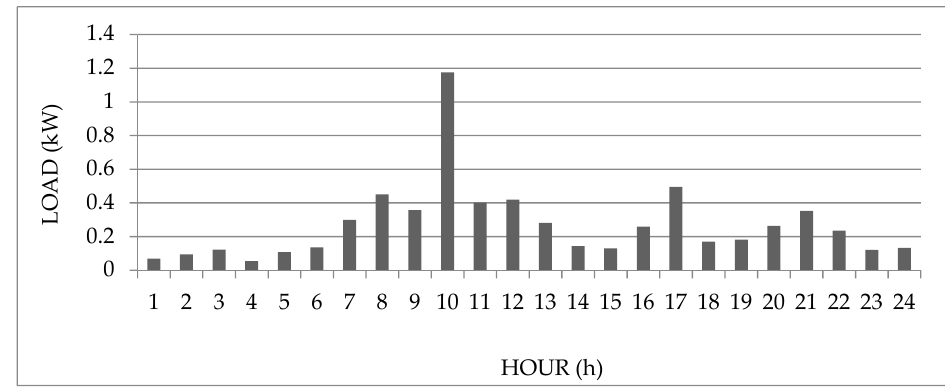
Figure 3. Load diagram.